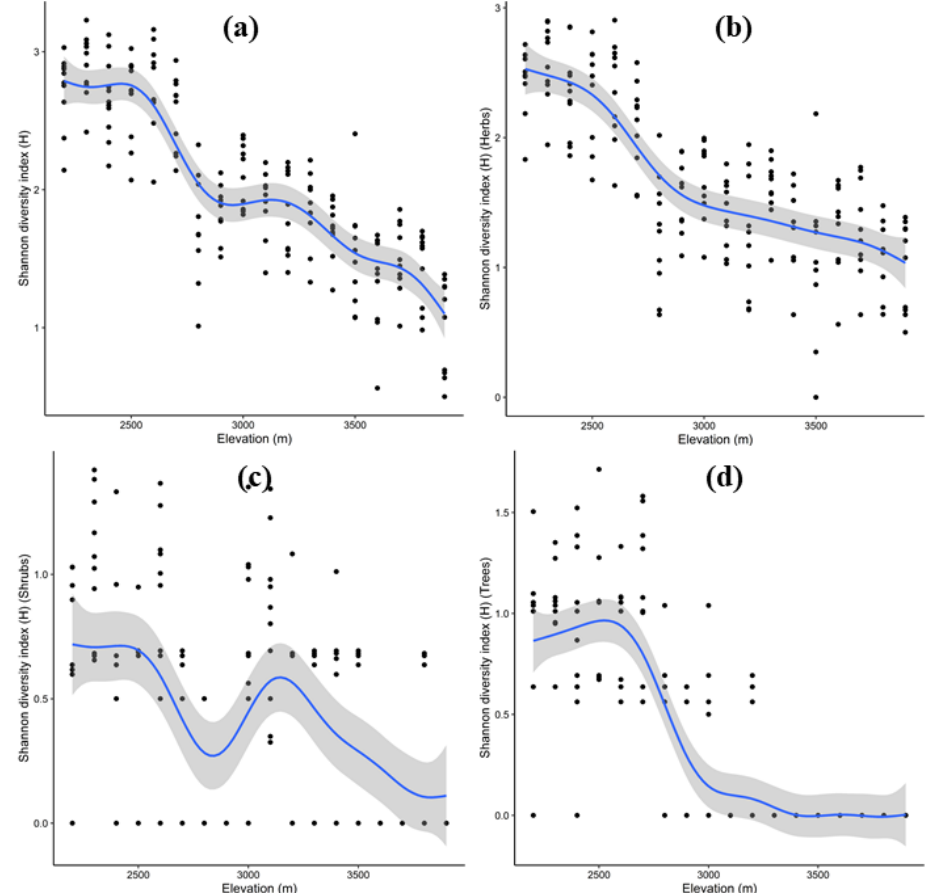
Figure 7. Relationship between elevation and Shannon diversity index for total ( a ), herb ( b ), shrub ( c ) and tree ( d ) recorded at 100 m elevation belts. Shown are the best-fitted regression splines from generalized additive model (solid blue line), standard errors (grey shadings) and observations (black dots).